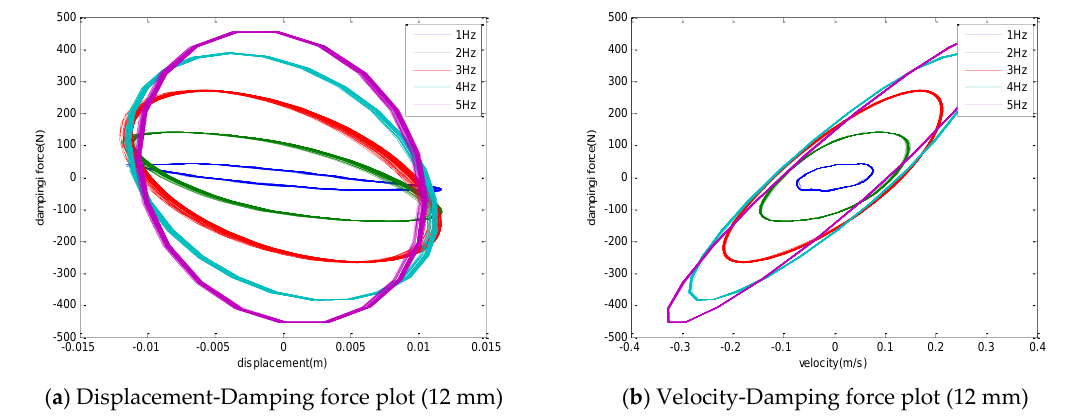
Figure 5. Hysteresis curve (12 mm, varying frequency).